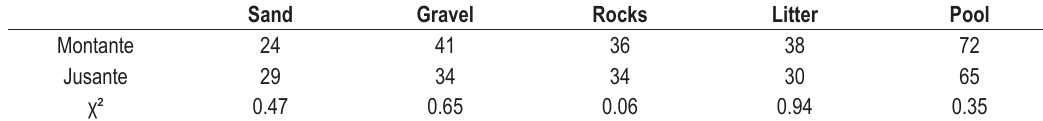
Figure 1. The correspondence analysis chart. Circle dots represent sampled substrates (D - downstream poll, and U start for upstream pool) and square dots represent taxa. Table 1. Richness differences among substrates as well as whole pools. Critical χ ² value = 3,14; DF = 3. Sand Gravel